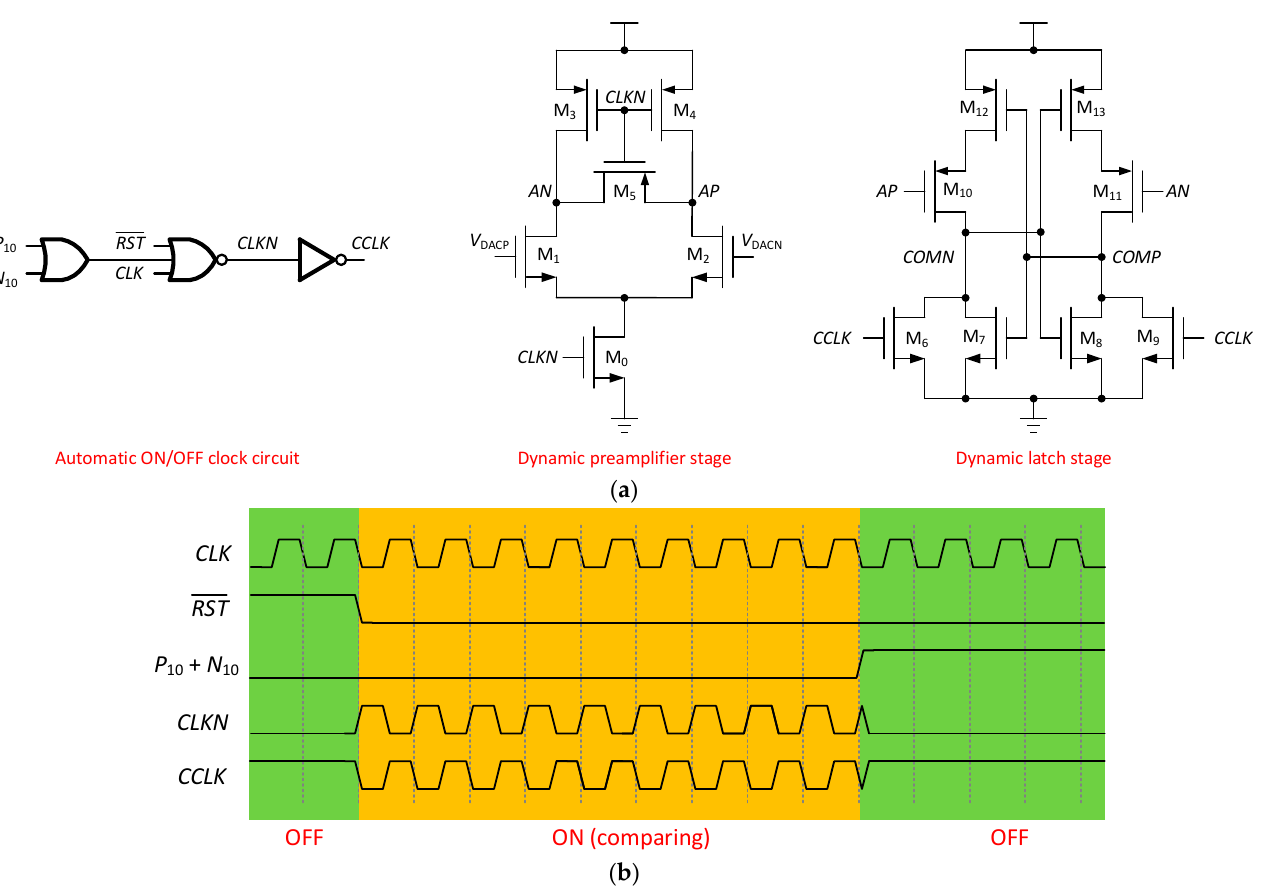
Figure 7. Automatic ON/OFF comparator. ( a ) Schematic diagram; ( b ) Timing diagram.